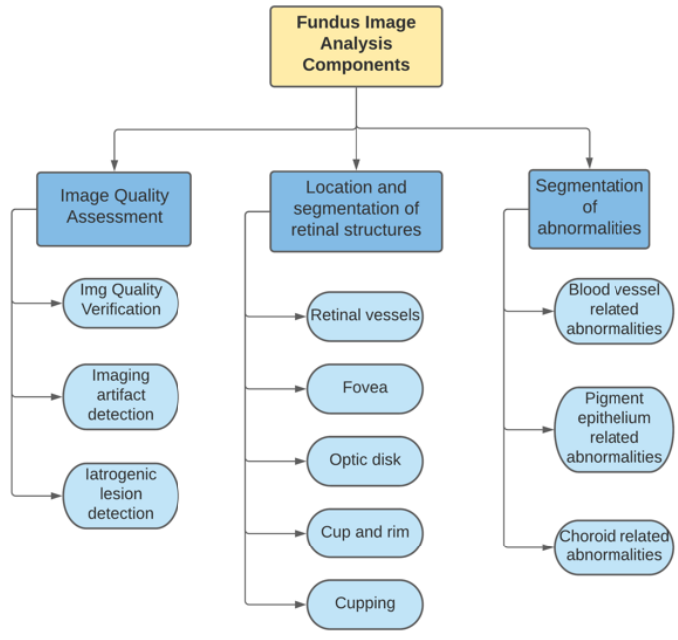
Figure 1. Fundus image analysis components as proposed by [14].